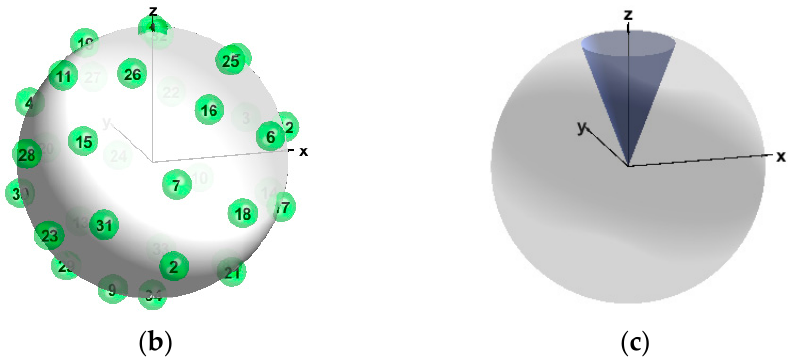
Figure 7. Permanent magnet placement on the rotor: ( a ) initial random distribution of 34 PMs on the surface of the rotor sphere; ( b ) distribution of 34 PMs after 2100 iterations of the NNM algorithm; ( c ) region of 0.38 sr designated for PM